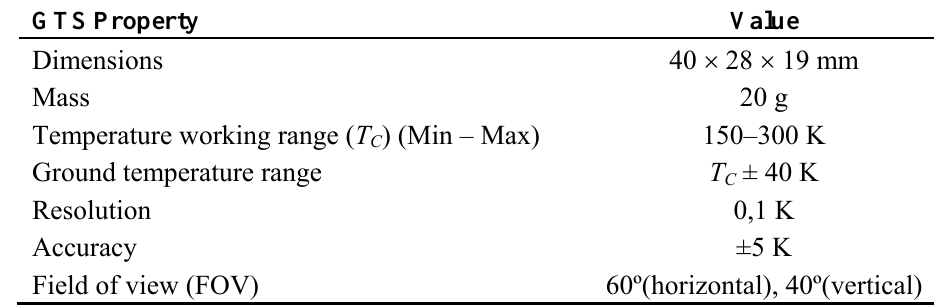
Table 2. GTS general characteristics (without electronics) and required